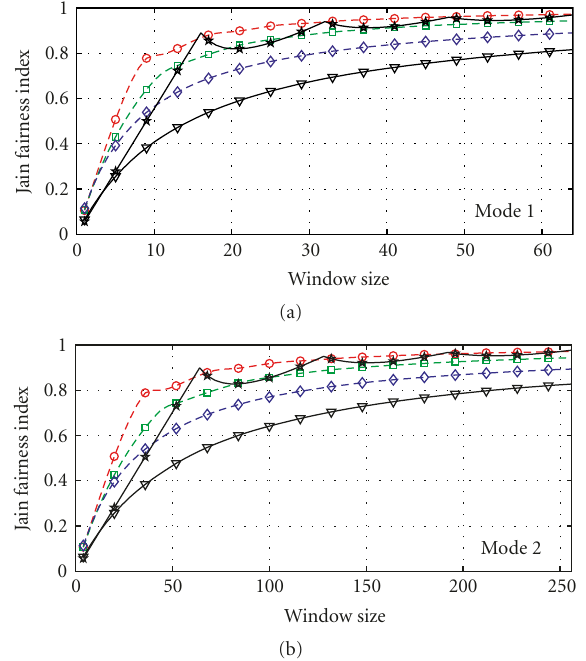
Figure 6: Virtual MIMO system throughput fairness index for two- antenna mode 1 ( K = 16) and mode 2 ( K = 64) in the presence of Rayleigh fading, constant Tx power ( P = 5dB), and channel norm CQI. Solid curves with stars (“ (cid:3) ”) refer to TDMA-RR, while solid lines with triangles (“ (cid:5) ”) correspond to TDMA-BUS. Dashed curves with circles (“ ◦ ”), dashed curves with squares (“ (cid:6) ”) and dashed curves with diamonds (“ (cid:14) ”) refer to pure ORR (ZFBF- PF fairness upper bound), ORR-Norm and ZFBF-SUS (ZFBF-PF fairness lower bound),